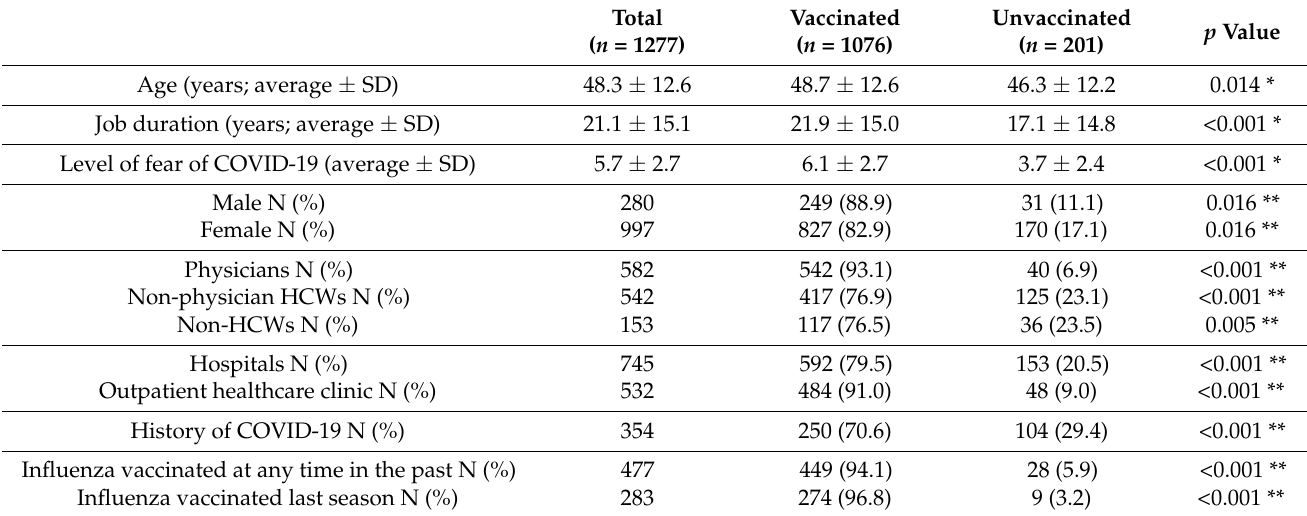
Table 1. Socio-demographic characteristics of